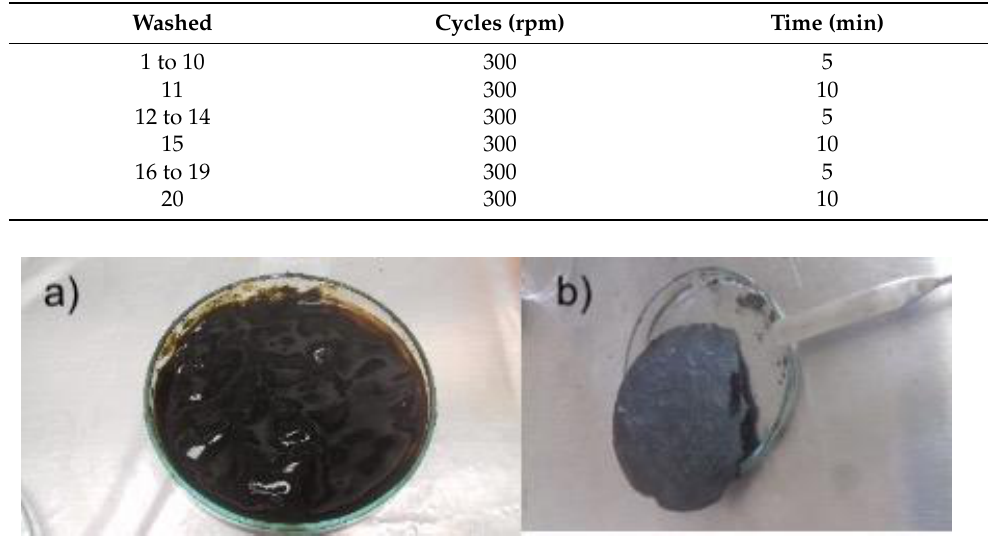
Figure 1. GO synthesis by the Hummers method: ( a ) after washing, ( b ) after drying.